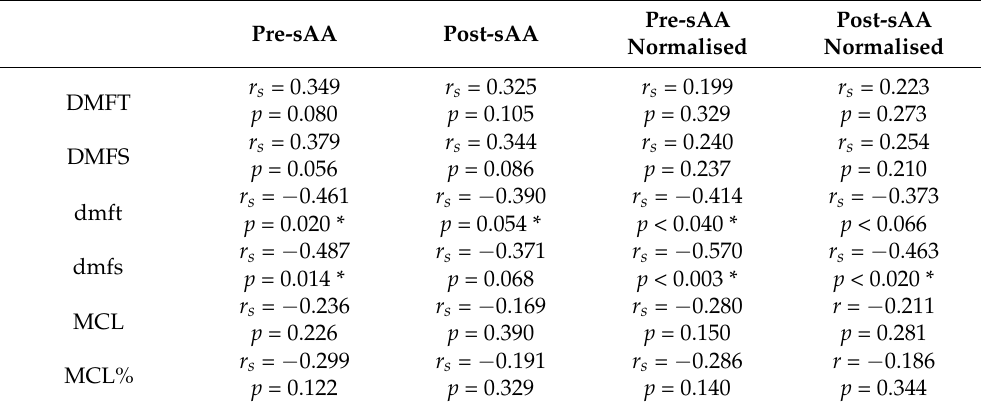
Table 2. Correlations between pre- and post-treatment levels of salivary alpha-amylase and carious experience.